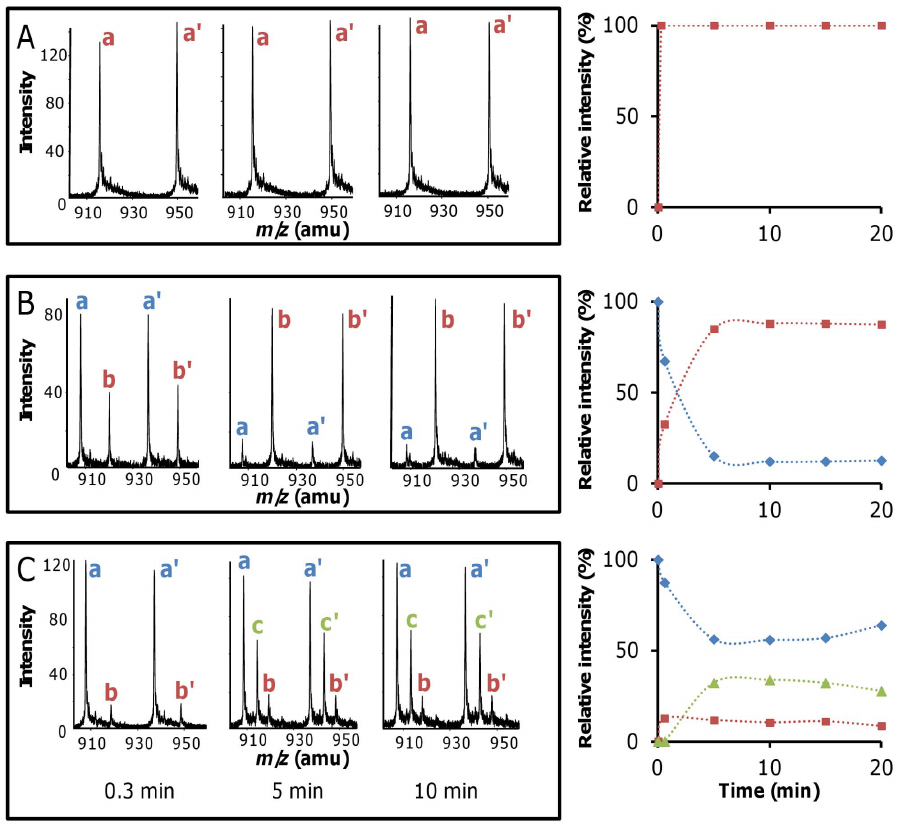
Figure 3. Mass spectrometry analysis of kinetics of Ldt fm inactivation by b -lactams. Ldt fm (20 m M) was incubated with 200 m M of b - lactams. Left panels, representative mass spectra obtained after 0.3, 5, and 10 min of incubation of Ldt fm with indicated b -lactams. Pair of peaks labeled with the same letter are [M + 32H] 32 + and [M + 31H] 31 + ions. (A) imipenem, peaks a and a’ at m / z 916.93 and 946.48 correspond to acylenzyme EI*. (B) Ceftriaxone, peaks a and a’ at m / z 907.58 and 936.84 correspond to free enzyme. Peaks b and b’ at m / z 919.95 and 946.60 correspond to acylenzyme EI*. (C) Ampicillin, peaks a and a’ ( m / z 907.52 and 936.79), b and b’ ( m / z 918.52 and 948.08), and c and c’ ( m / z 913.51 and 942.95) correspond to free enzyme, EI*, and EI**, respectively. Right panels, kinetics of Ldt fm - b -lactam adducts formation. Relative intensities were deduced from peak heights. Blue diamond, free enzyme; Red square EI*; Green triangle EI**.